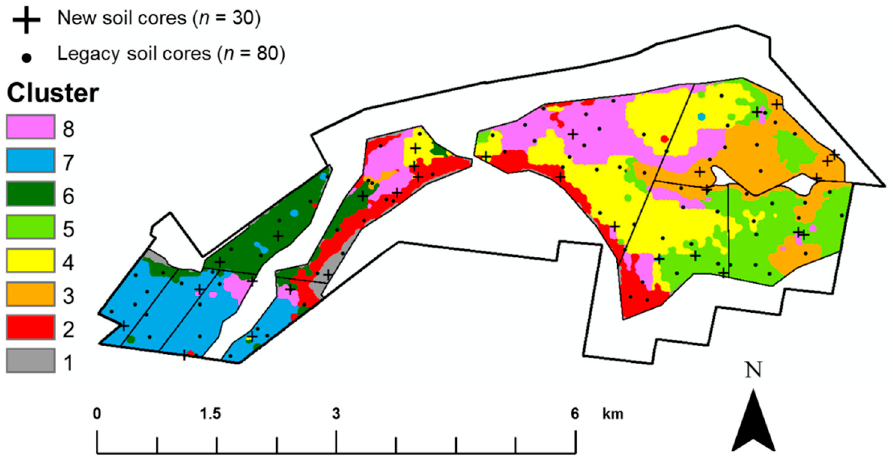
Figure 2. The distribution of the eight clusters derived from a k-means clustering analysis, and the locations of the soil sampling sites across the study area.